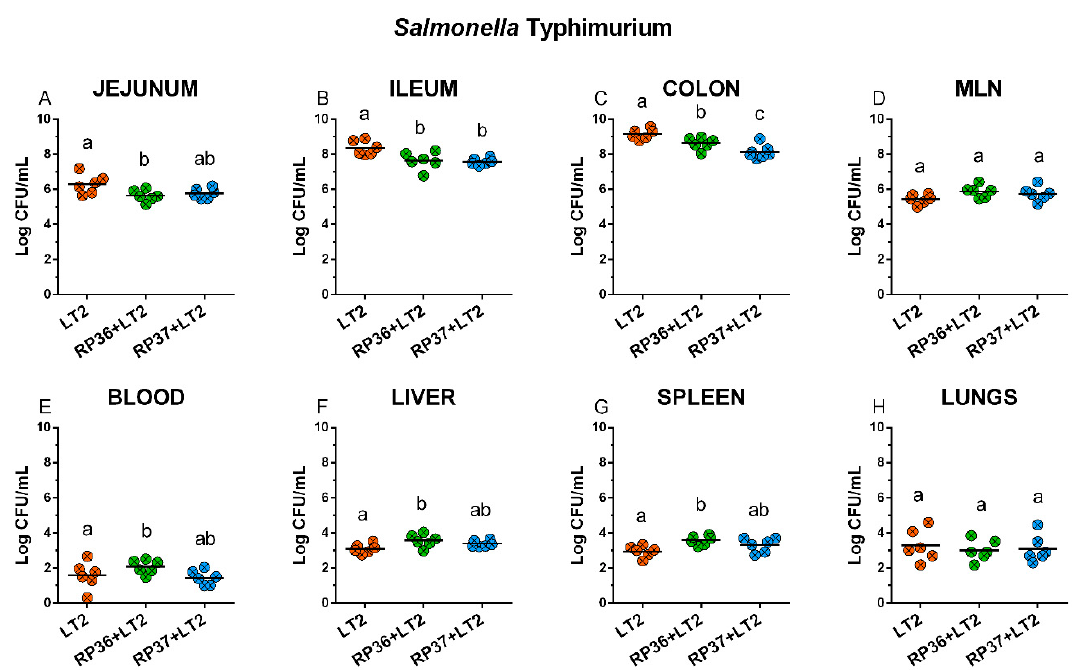
Figure 3. S. Typhimurium counts in the intestine, mesenteric lymph nodes (MLN), blood, liver, spleen, and lungs. S . Typhimurium strain LT2 (LT2) colony-forming units (CFU) were counted in the jejunum ( A ), ileum ( B ), colon ( C ), mesenteric lymph nodes (MLN; ( D )), blood ( E ), liver ( F ), spleen ( G ), and lungs ( H ). S . Typhimurium (LT2) and its interferences with B. boum strains RP36 (RP36+LT2), and RP37 (RP37+LT2) were evaluated by one-way ANOVA with Tukey’s multiple comparisons post-hoc test. Statistical differences were marked by a letter system at p ˂ 0.05. The same letter means no statistical significance. Log CFU are depicted as individual spots with mean as a horizontal line and n = 6 for all groups.